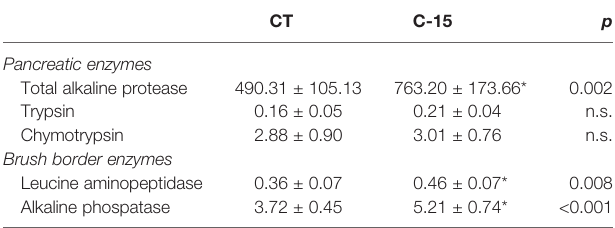
TABLE 6 | Enzyme activities (U g tissue − 1 ) measured in the whole intestinal extracts of juvenile C. labrosus fed control (CT) and C-15 diets during 90 days.